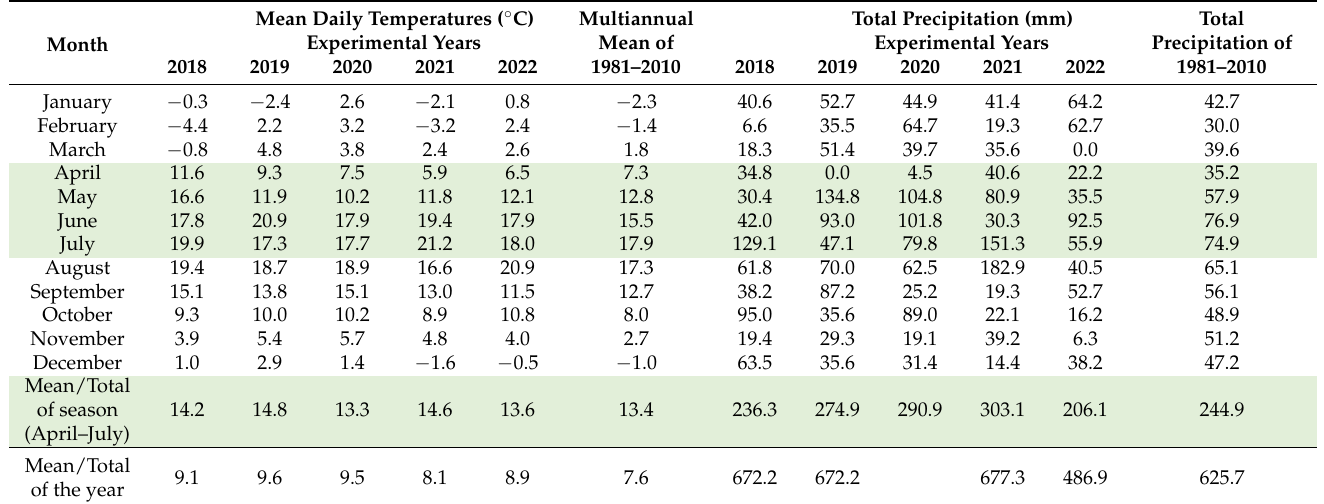
Table 1. The mean monthly values of weather parameters in Olsztyn (north-eastern Poland) in 2018–2022 and the multiannual mean (data obtained and processed from the IMGW-PIB station of the Institute of Meteorology and Water Management).